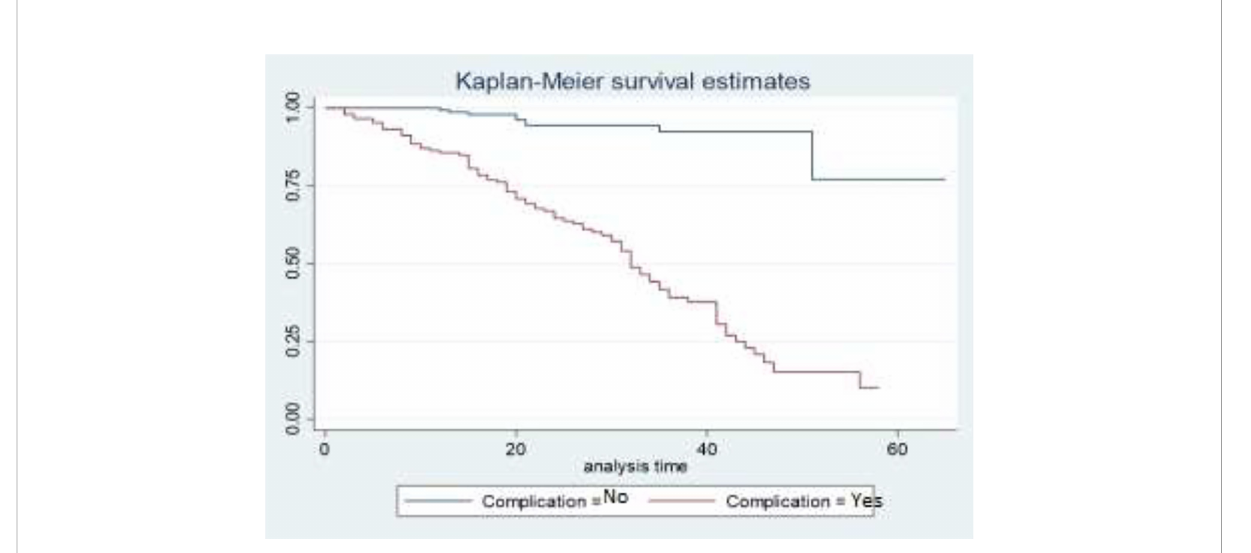
FIGURE 3 Survival curves of complication status.